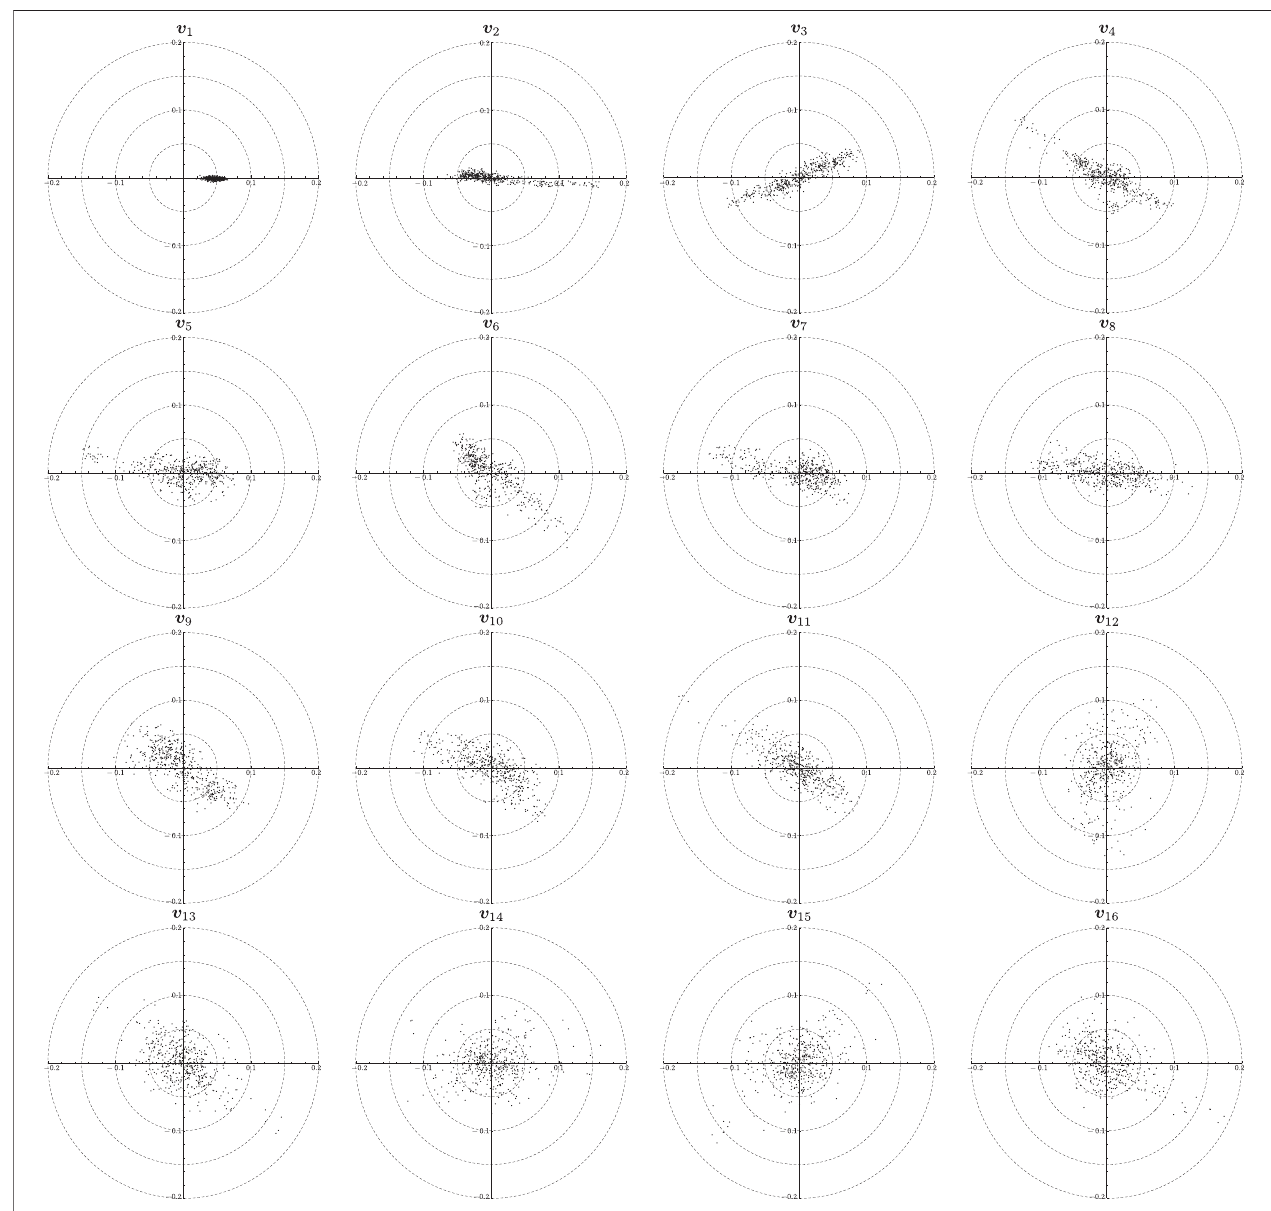
FIGURE 10 | Distribution of components of the top 16 eigenvectors, v 1 , ... , v 16 . In each fi gure, the abscissa represents R ( v R , n ) , and the ordinate represents I ( v ) . Here, R is the eigenvalue R , n